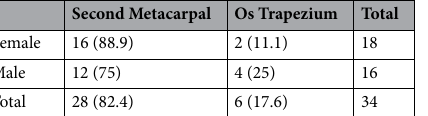
Table 3. Distribution of FCRB insertion sites [n (%)]. FCRB musculus flexor carpi radialis